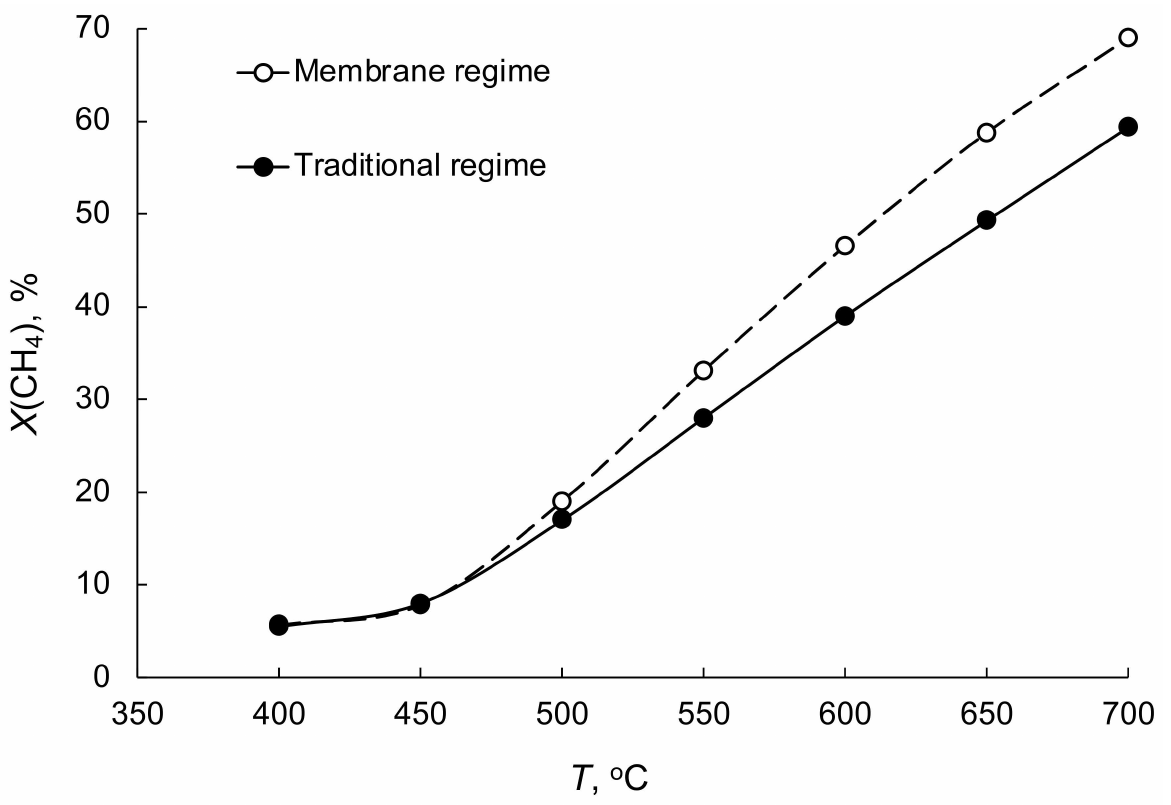
Figure 9. Comparison of temperature dependences of methane steam reforming accompanied by ultrapure hydrogen extraction from the reaction zone (membrane process) and without extraction (traditional